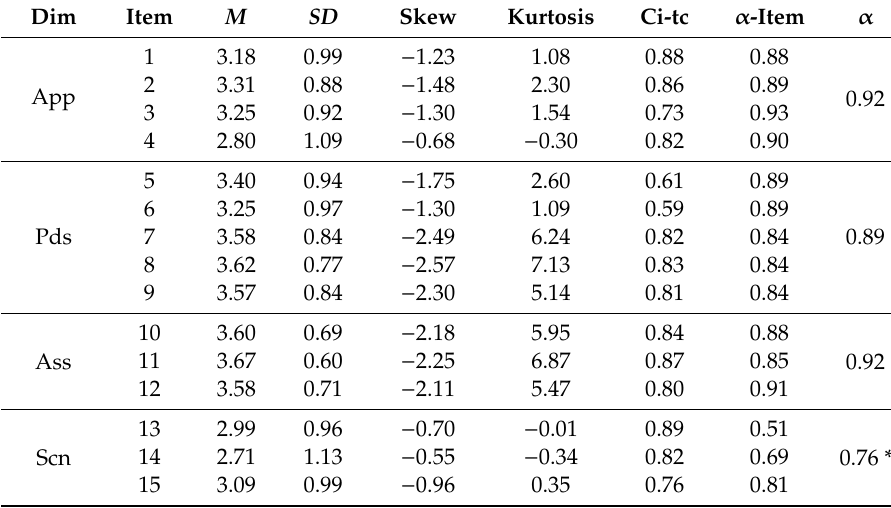
Table 5. Some psychometric item